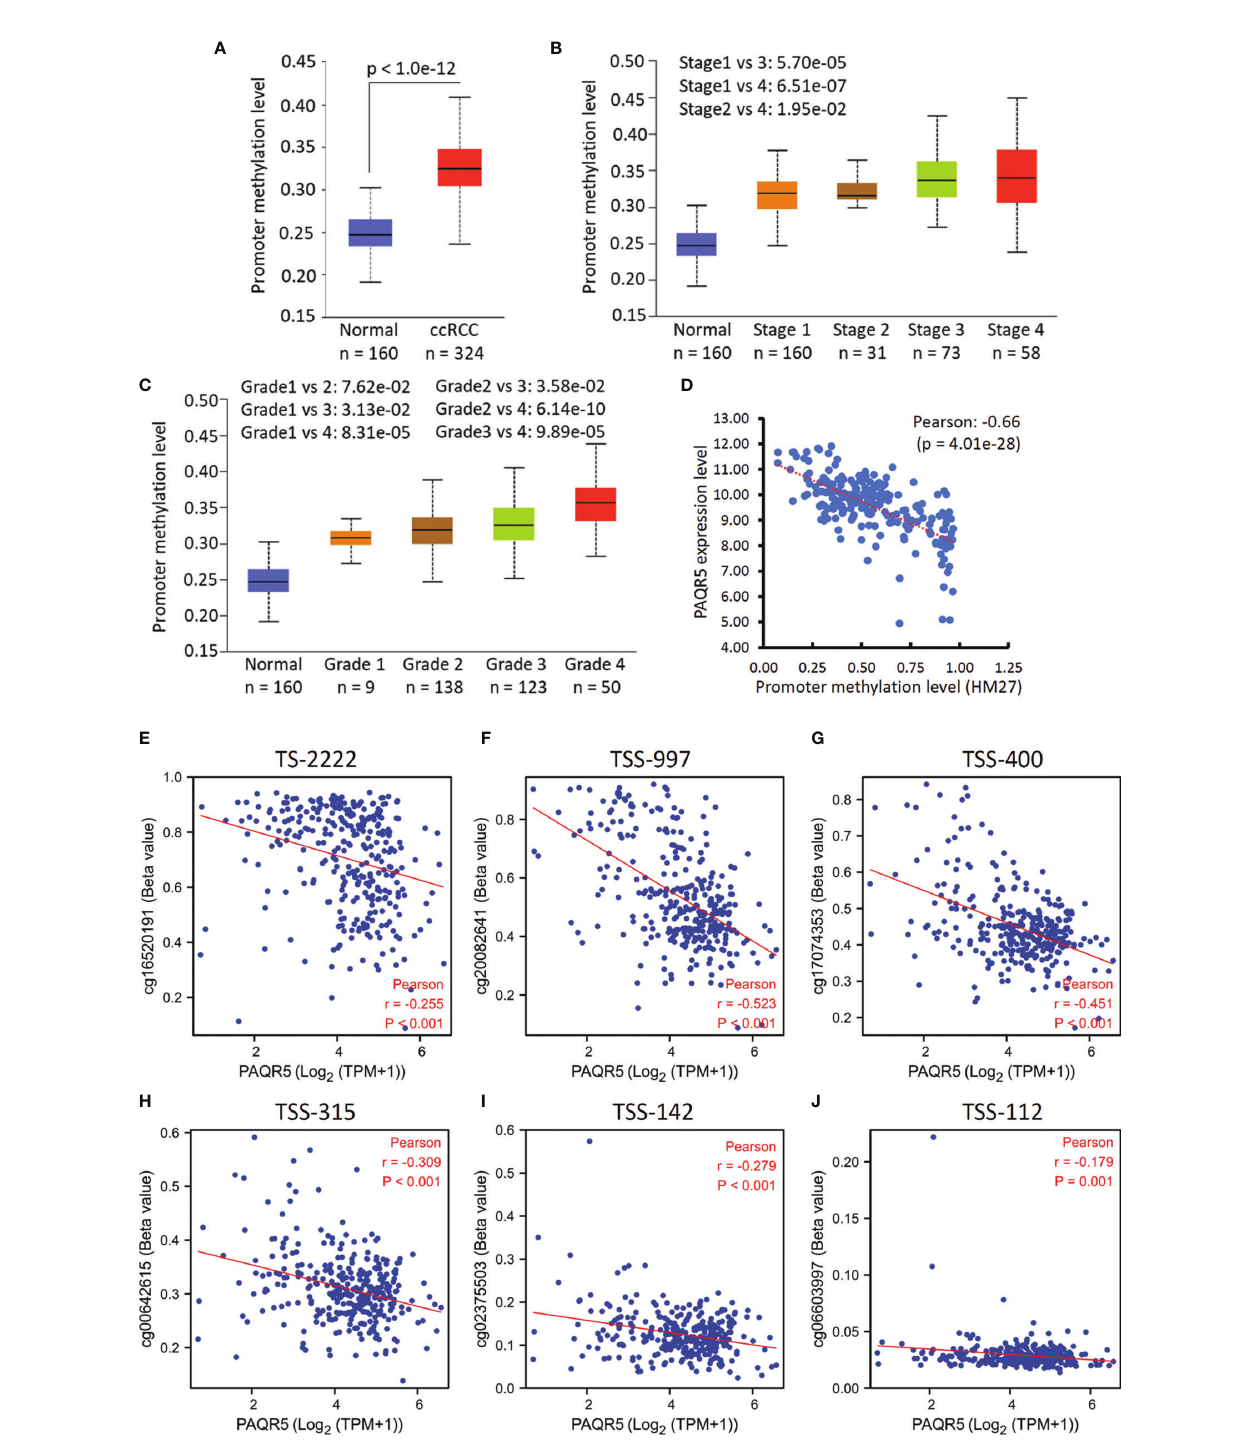
FIGURE 3 | PAQR5 promoter methylation is increased in ccRCC tissues. (A – C) Promoter DNA methylation on the PAQR5 gene was analyzed using the TCGA dataset (HM450 BeadChip) derived from ccRCC tissues on the UALCAN platform (29, 30). Tumor stage and cancer grade were set as the variables for multiple group comparison with ANOVA analysis followed by Student t -test. Case numbers were listed in each sub-group at the bottom. (D) Pearson coef fi cient analysis was conducted using the TCGA Firehose Legacy RNAseq dataset (HM27 BeadChip) downloaded from the cBioportal platform (case number = 217). (E – J) Pearson coef fi cient analysis was conducted between PAQR5 expression and the DNA methylation levels in a different region upstream of the TSS site using the TCGA RNAseq dataset (HM450